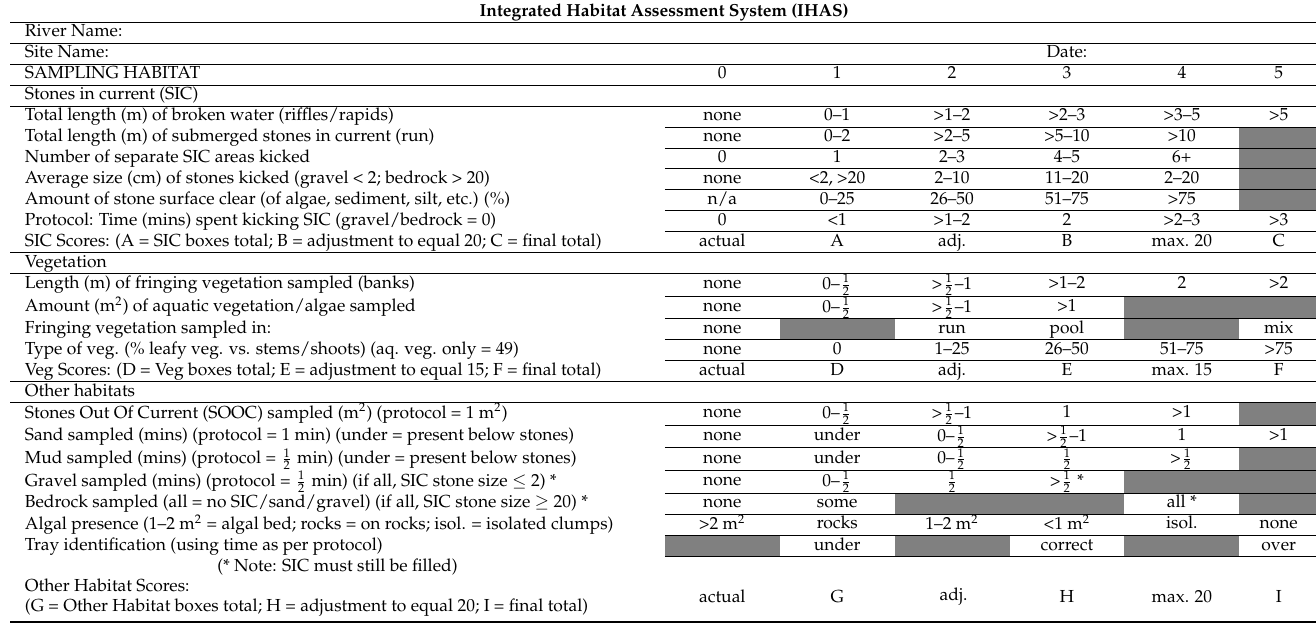
Table A1. A sheet for integrated habitat assessment score (adapted from McMillan